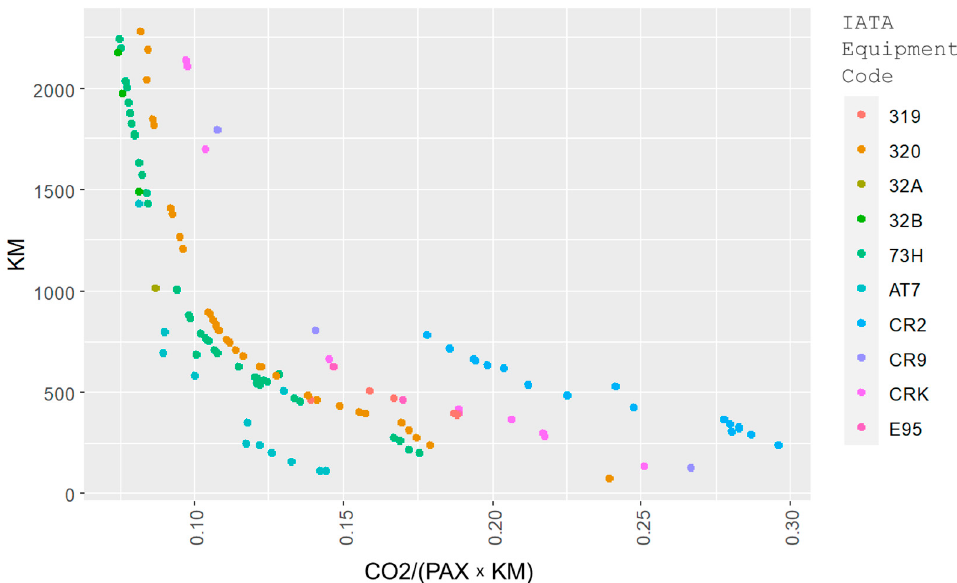
Figure 12. The relative ratio of carbon dioxide emissions in kilograms (kg) per passenger (PAX) and kilometer (km) according to the distance traveled in kilometers (km) by each aircraft selected. Source: own elaboration based on data compiled from [19] and weighted from [20].